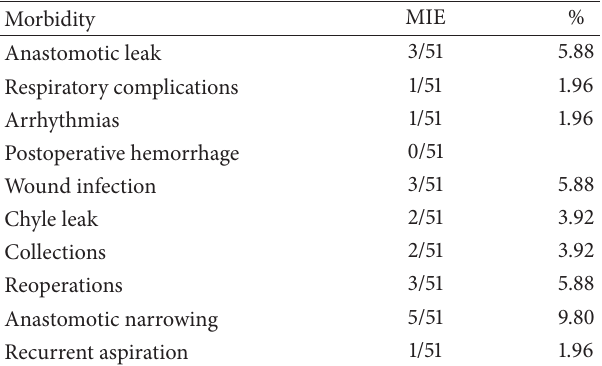
Table 2: Morbidities for MIE.